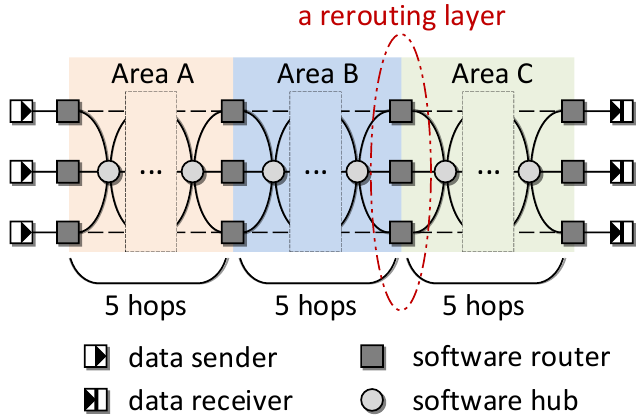
Figure 9. The IoV simulation topology built by the IoV test